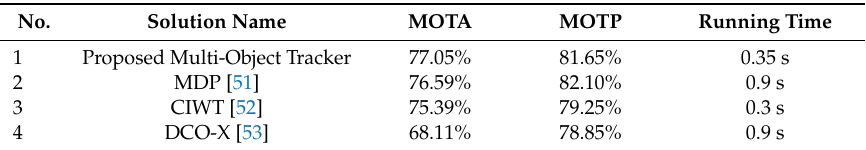
Table 7. Comparison with solutions from the KITTI benchmark.